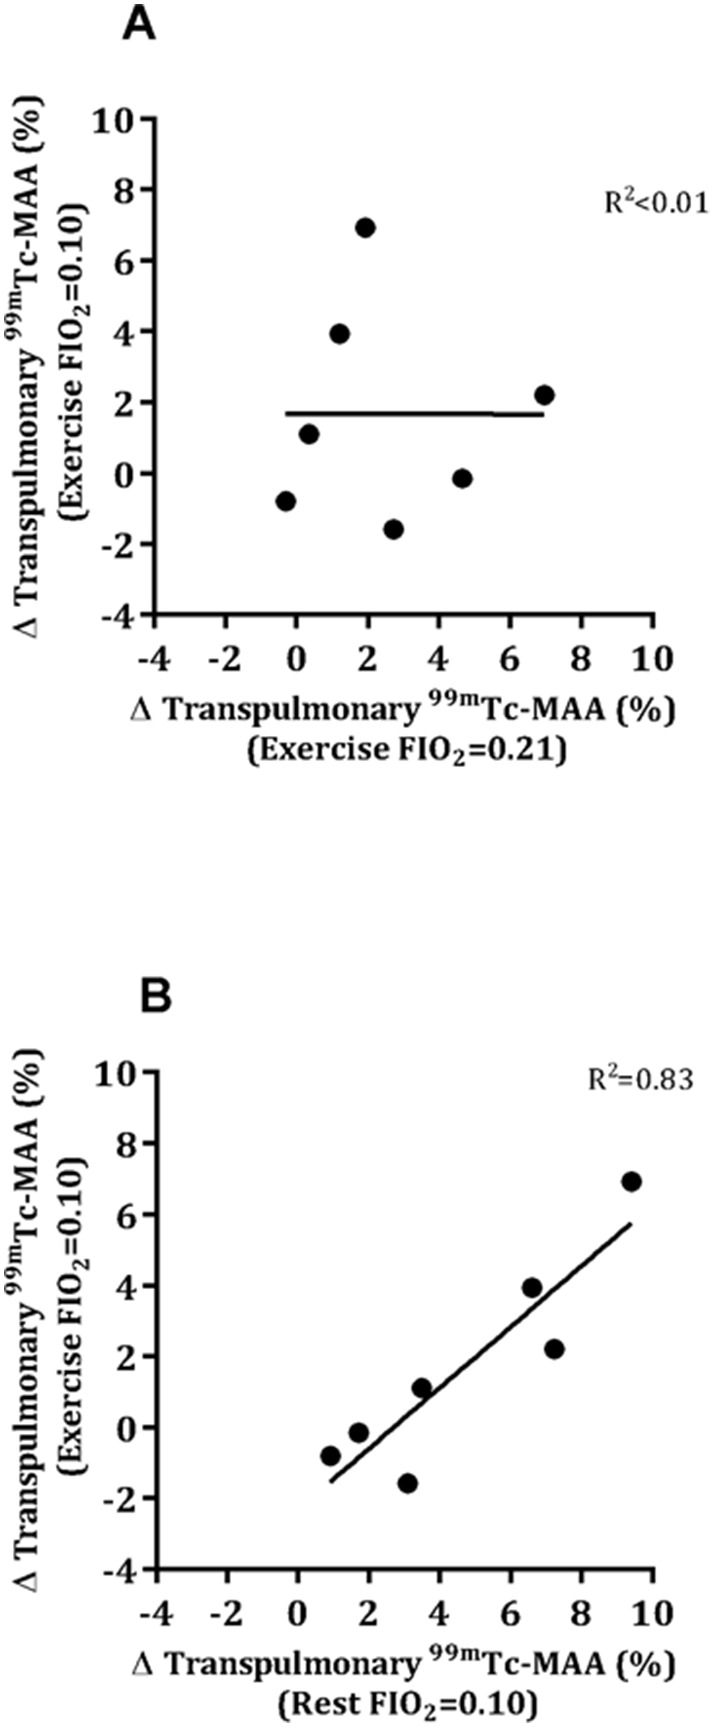
Relationship between transpulmonary 99mTc-MAA passage with exercise in normoxia vs. hypoxia (A) and between rest and exercise in hypoxia (B).The transpulmonary passage of 99mTc-MAA with exercise in hypoxia was well-correlated with that measured at rest with hypoxic gas breathing. Dashed line indicates the line of identity.